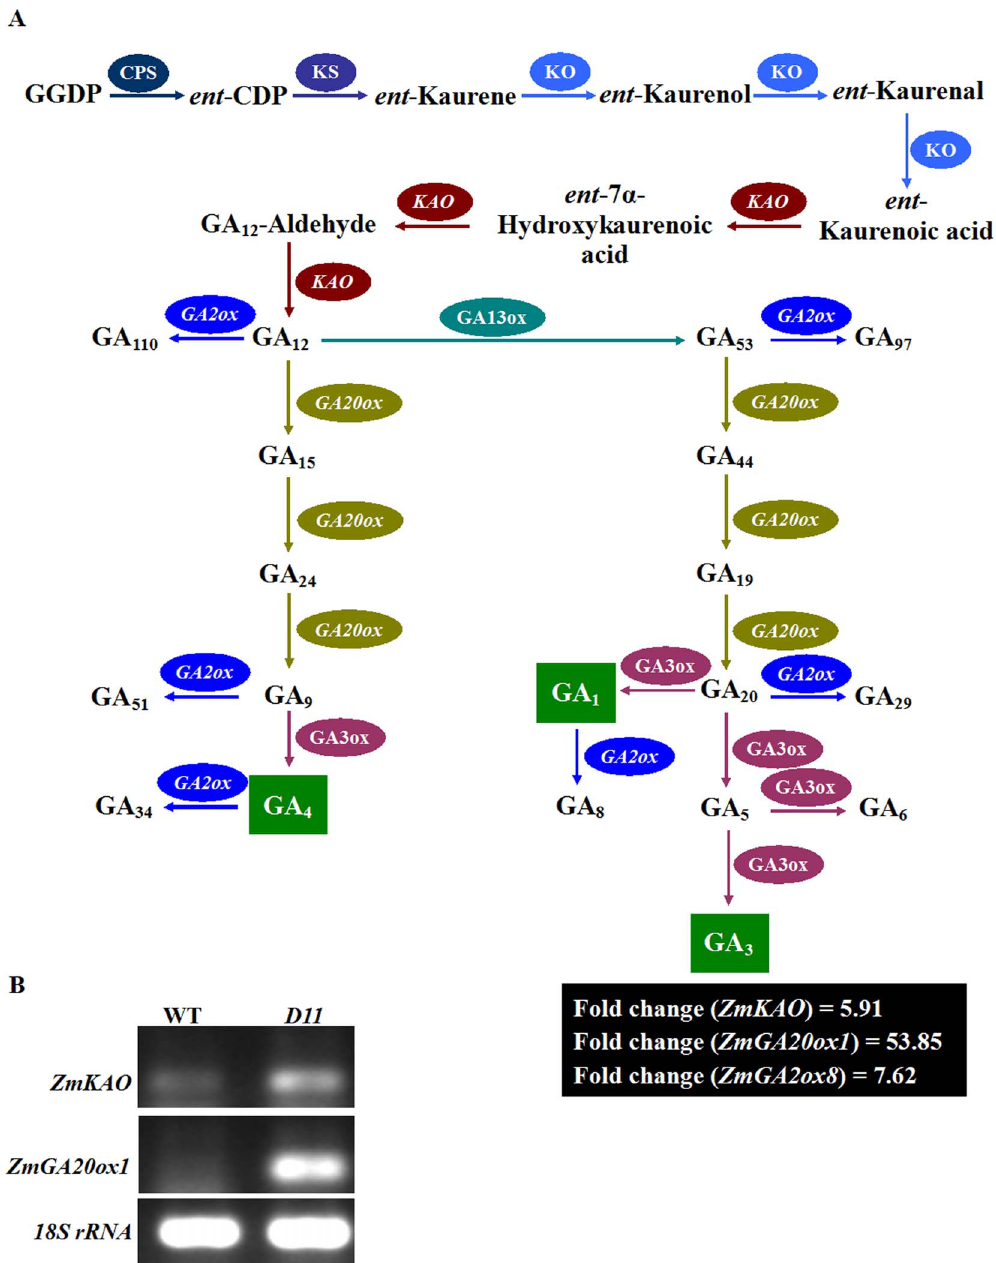
Figure 4. DEGs involved in GA biosynthesis and catabolism. ( A ) GA biosynthesis and catabolism pathways were briefly diagramed. Transcripts encoding maize GA biosynthetic and catabolic enzymes ZmKAO, ZmGA20ox1, and ZmGA2ox8 are up-regulated in D11 . ( B ) Semi-qRT-PCR validation of elevated transcripts ZmKAO and ZmGA20ox1 . The 18S rRNA gene was used as an internal control.